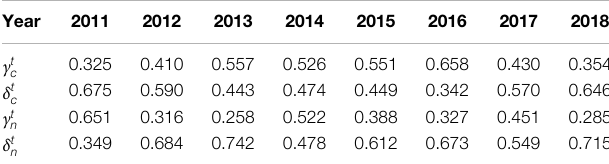
TABLE 7 | Coef fi cients of stock increment for both the conventional and the nonconventional in 2011 –